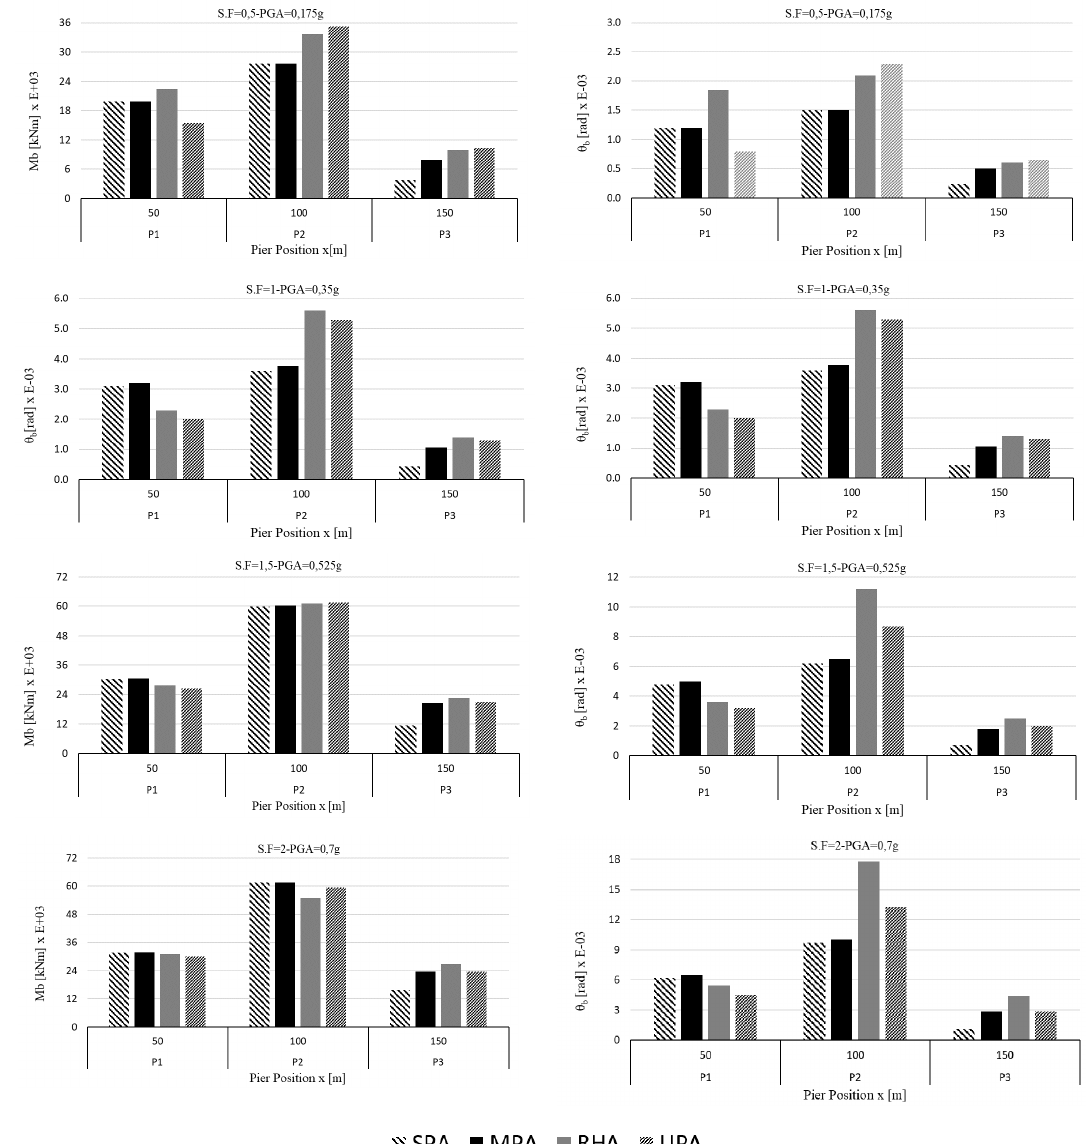
Figure A4. Irregular bridge—bending moment (M b ) and curvatures (q b ) at the hinge location, derived by performing nonlinear dynamic analysis and pushover analysis (PGA from 0.175 to 0.7 g).